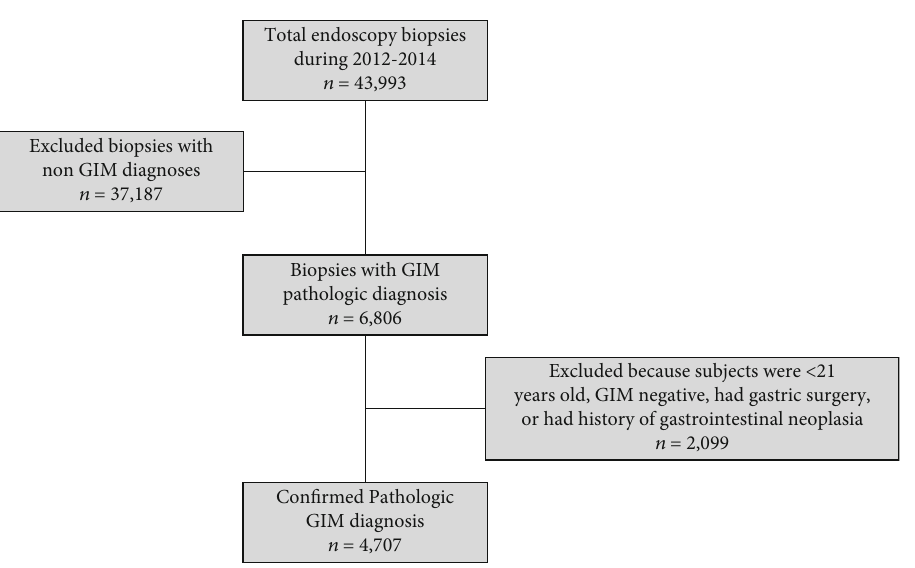
Figure 1: Flow chart of inclusion and exclusion process. Table 1: Demographic and clinicopathological characteristics of patients diagnosed with GIM during 2012-2014 ( n = 4,707